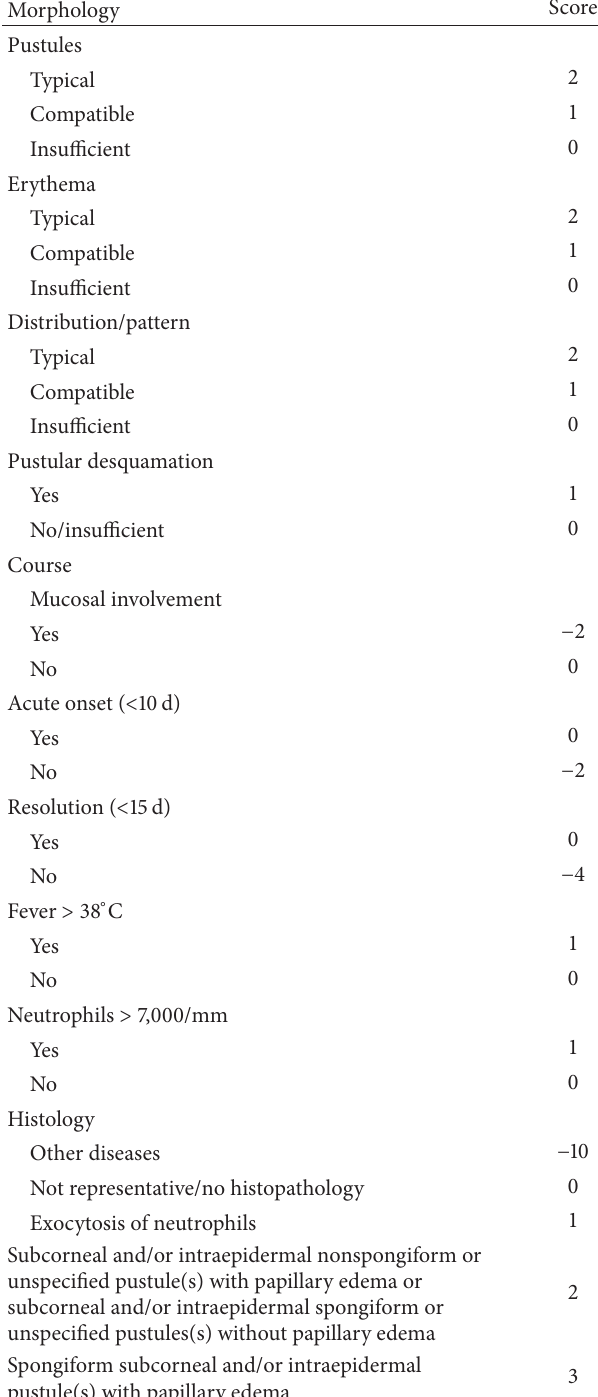
Table 1: Acute generalized exanthematous pustulosis validation score of the EuroSCAR study group